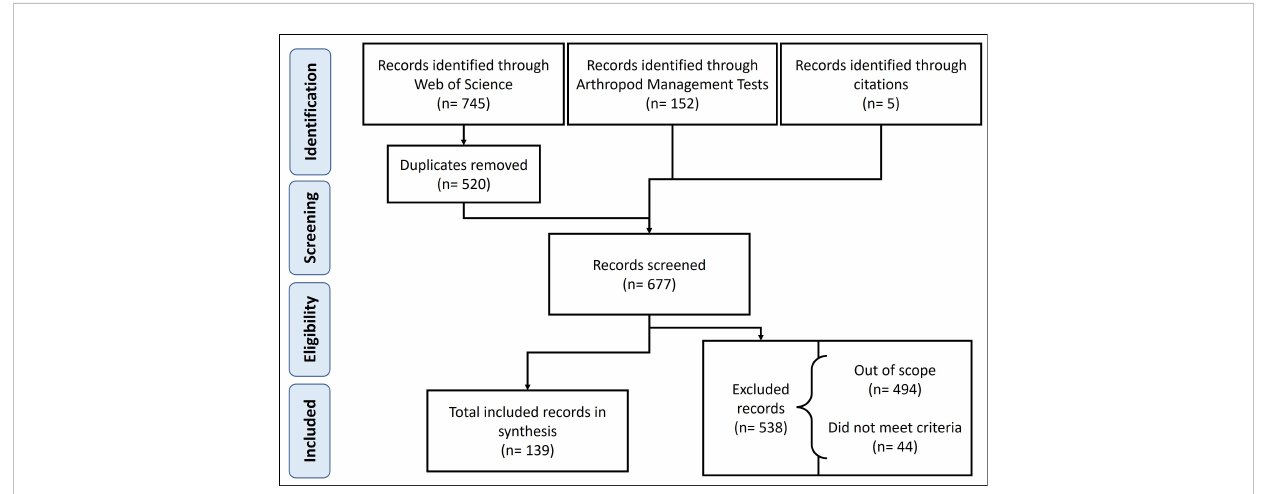
FIGURE 4 PRISMA fl ow diagram depicting the steps to the literature review. The scope of our paper was on cranberry insect IPM, and to meet our criteria for inclusion the article had to be published in a peer- or editor-reviewed journal and in the years 1990 to